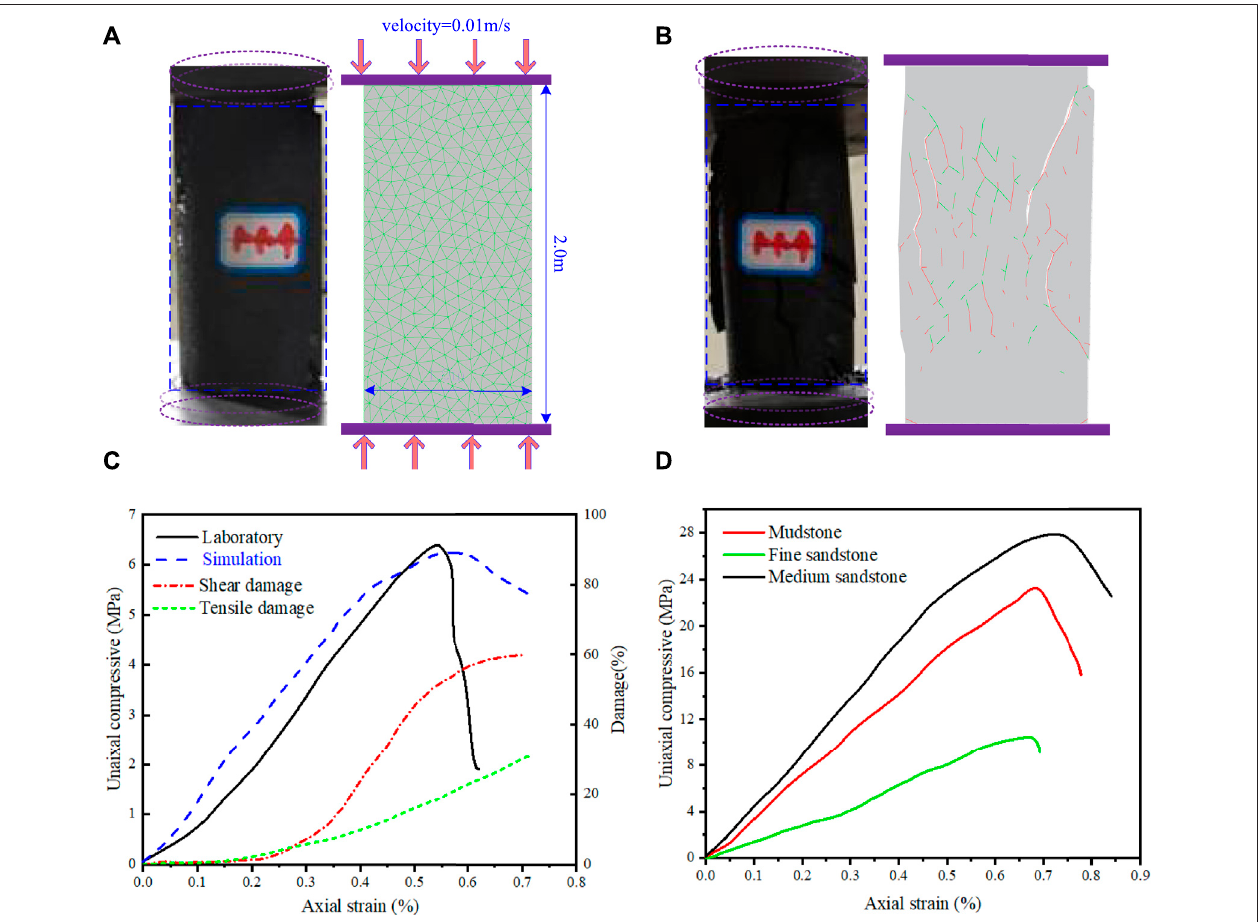
FIGURE 6 | UDEC Trigon models calibration result for UCS testing. (A) The samples using for UDEC Trigon and laboratory testing; (B) The failure and cracking characteristics ofUDEC Trigon and laboratorysamples; (C) Stain-stressand damage curvesofcoal sample; (D) The strain-stresscurvesofthree rock types of samples are acquired by the numerical